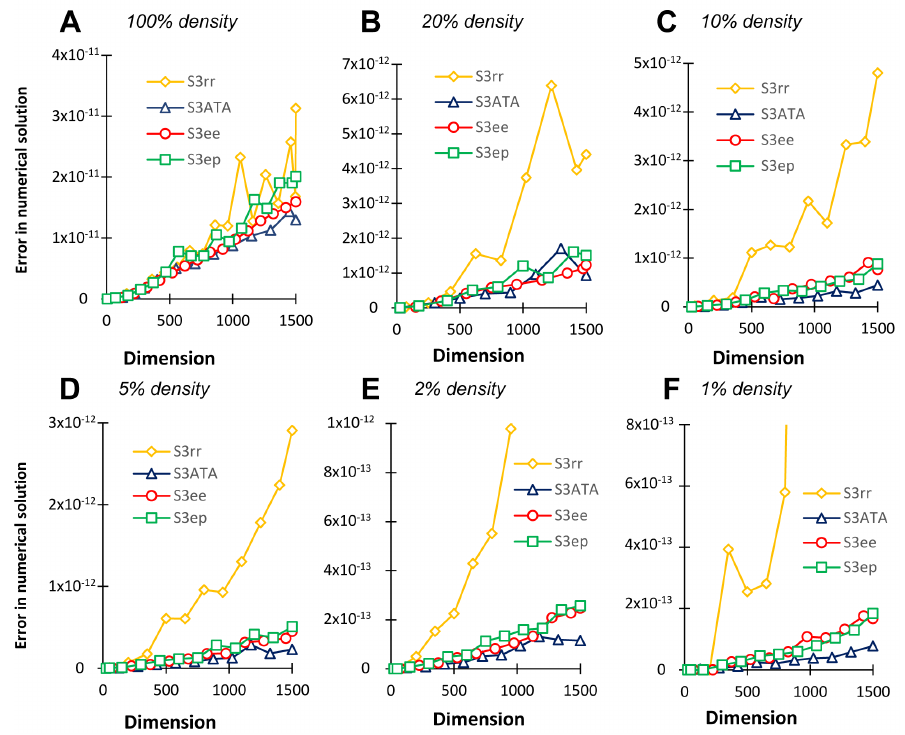
Figure 3. Comparative analysis of the four variants of orthogonally scaled complex ABS algorithm on randomly generated matrices with different